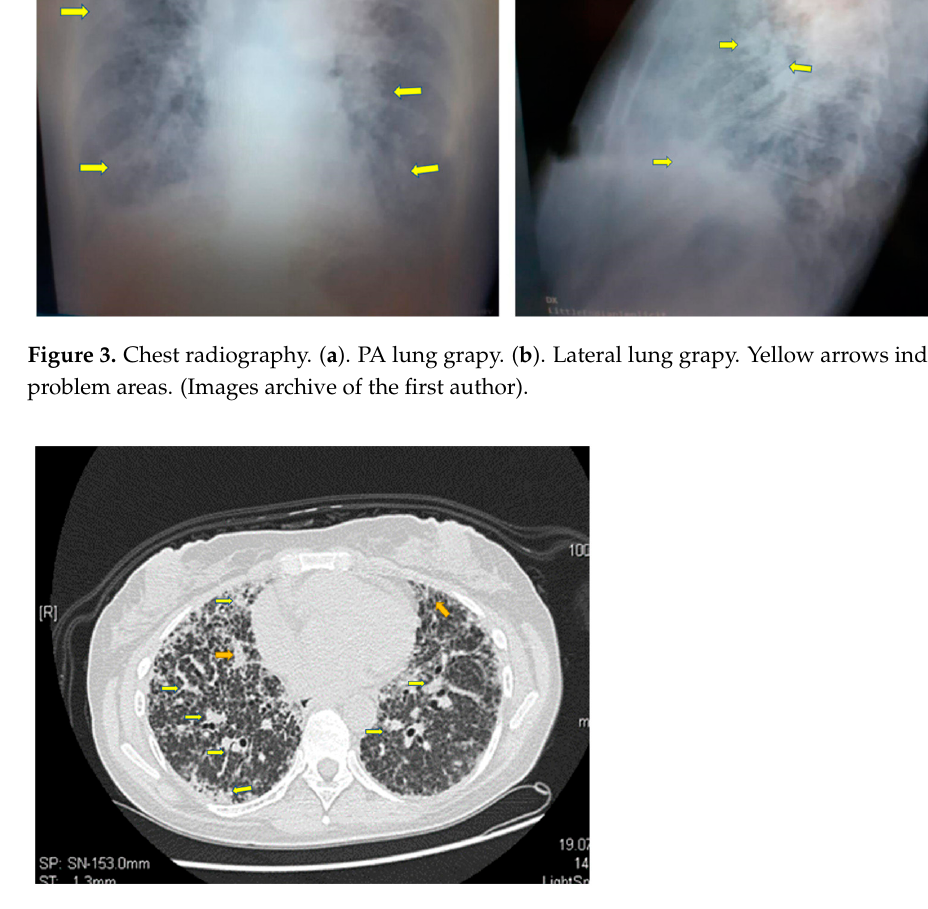
Figure 4. Infrahilar axial section. Polymorphous bilateral pulmonary appearance with marked augmentation with thickening of irregularly shaped interstitial septa and local pulmonary tractions. Yellow arrows indicate the problem areas. (Computed tomography scan of the lungs from the archive of the first author.)